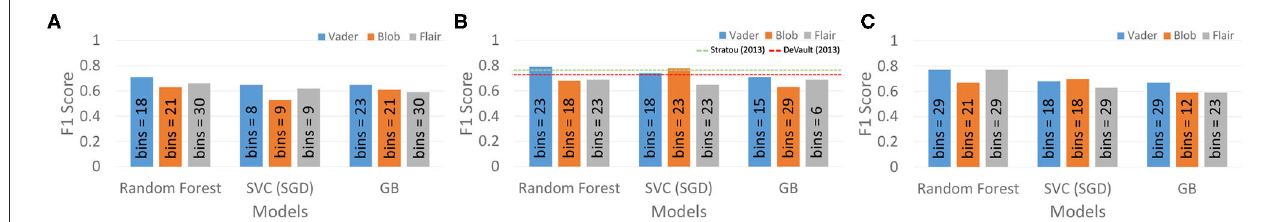
FIGURE 3 | Machine learning results (F1 score) from partitioned types. (A) Five-fold-CV, (B) Original Train-Test-Split, and (C) 2017-to-2019. High watermark results from each model, sentiment analyzer and bin size for all 3 partitioning methods. The RF (23 bins) with VADER on the original train-test-split folds achieved the highest accuracy (80.4 %) and an F1 score (0.79). Panel (B) displayed the benchmark F1 scores from two other studies. In the agnostic five-fold-CV, the RF (18 bins) with VADER achieved the best accuracy (75.6 %, STD = ± 4.5 %, F1 score = 0.71). The dashed lines represent the results from Stratou et al. (27) and DeVault et al. (26), who tried to predict PTSD on a smaller version of this current